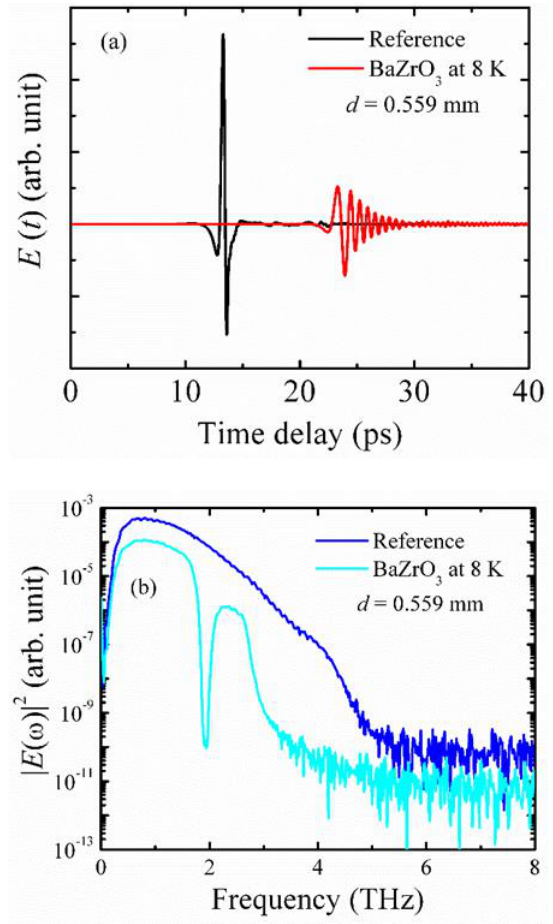
Figure 7. ( a ) Time-domain waveform and ( b ) the power spectra of a BaZrO 3 single crystal converted from time-domain waveforms at 8 K.